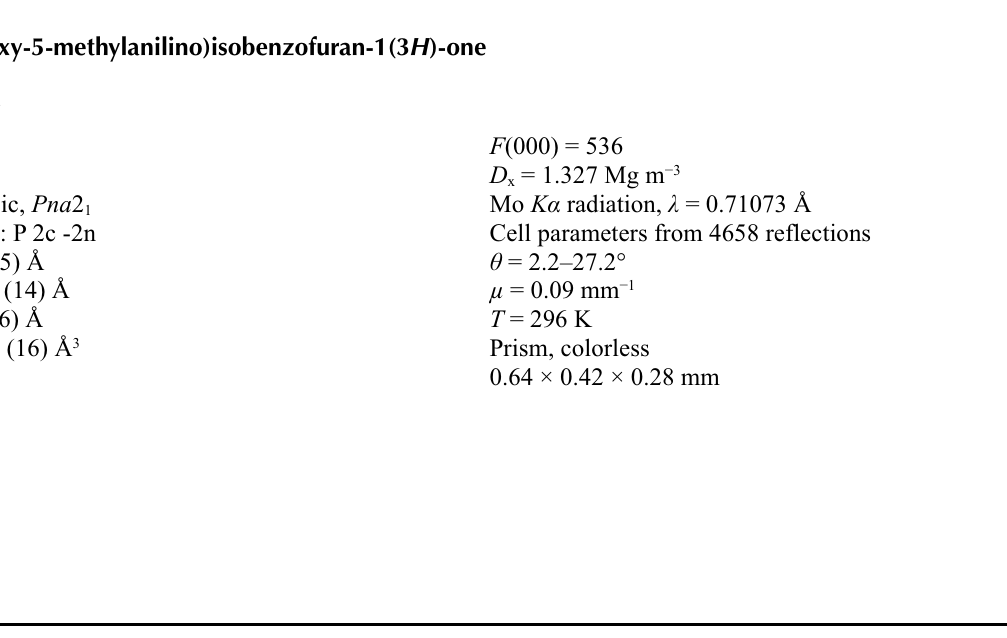
A partial packing diagram of (I). Hydrogen bonds are shown as dashed lines [symmetry code: (i) 1 - x, -y, z + 1/2]. H atoms not involved in hydrogen bondings have been omitted for